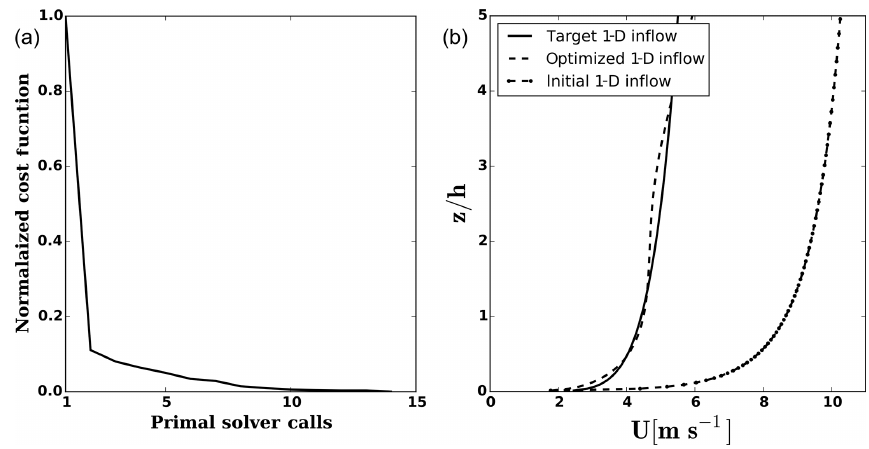
Figure 7. Optimization history (a) and inlet velocity profile comparison (b) .